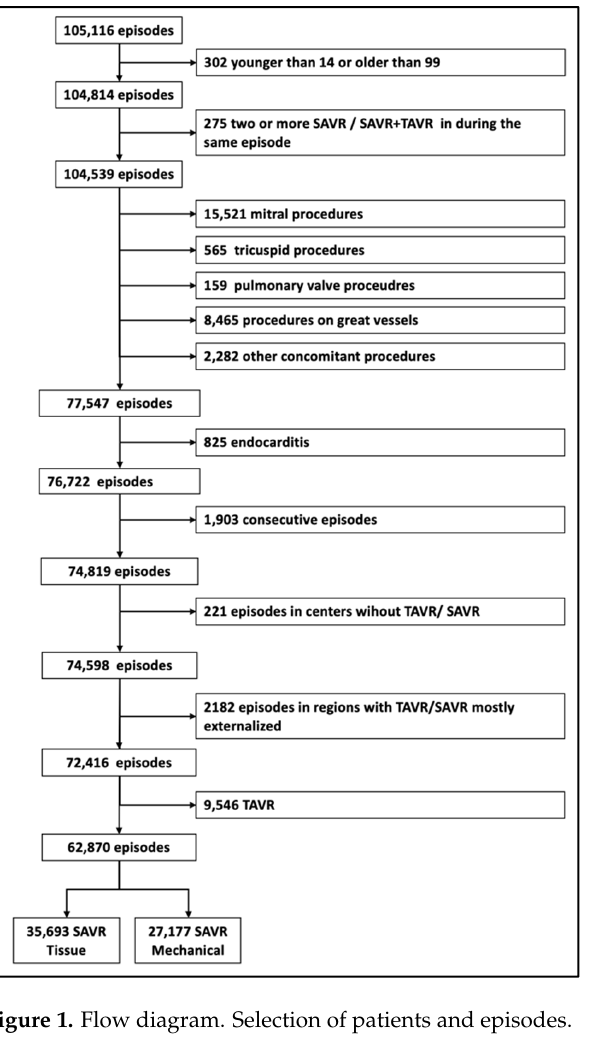
Figure 1. Flow diagram. Selection of patients and episodes.